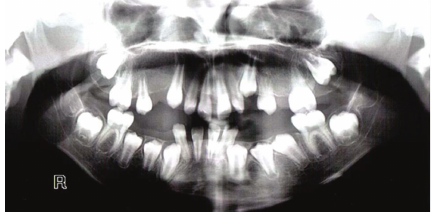
Figure 7: Panoramic radiograph showing normal development of permanent teeth and missing of maxillary right first and left second premolars.